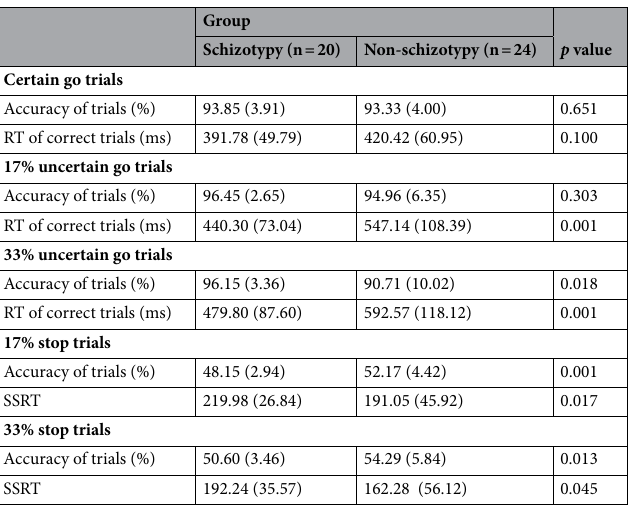
Table 1. Behavioural results on stop signal task [mean (SD)]. RT response time, SSRT stop signal reaction time.